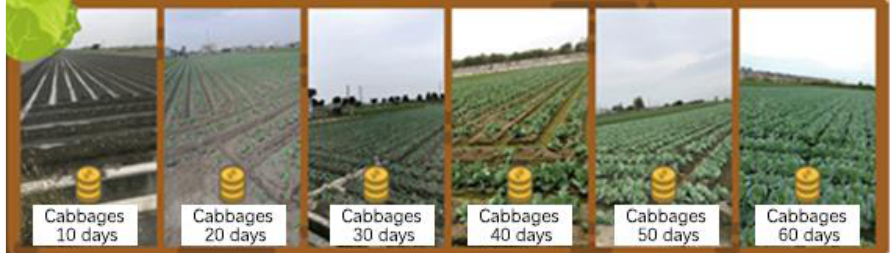
Figure 11. Agricultural professionals interpret the growth days of cabbages according to the field survey images.